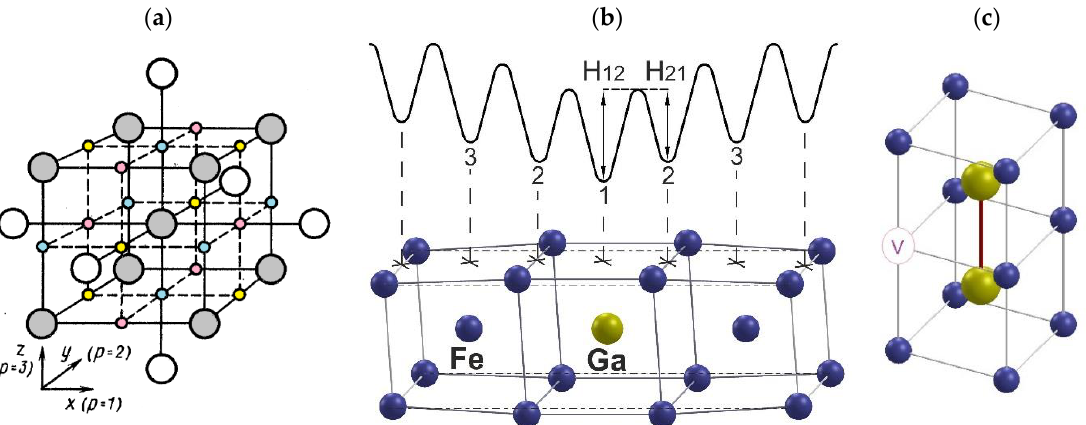
Figure 5. Octahedral interstices in the bcc crystal lattice: large circles are metal atoms; small circles are interstices of the sublattices p = 1, 2, and 3 ( a ); scheme of the dependence of the energy of an interstitial atom in octahedral interstices in the (001) plane of A 2 or D 0 3 lattice on the distance from the substitute atom (e.g., Ga) ( b ); and a complex of pair of SA and vacancy ( c ).